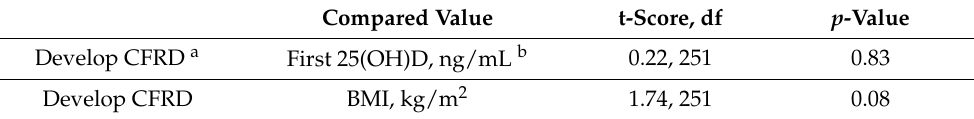
Table 3. Sub-group analysis of subjects developing CFRD during the course of the